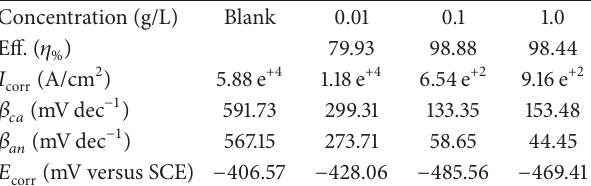
Table 5: Potentiodynamic polarization parameters for pipeline SO with and without different concentrations of steel in 0.5 M H 2 4 Brassica oleracea extract at 333